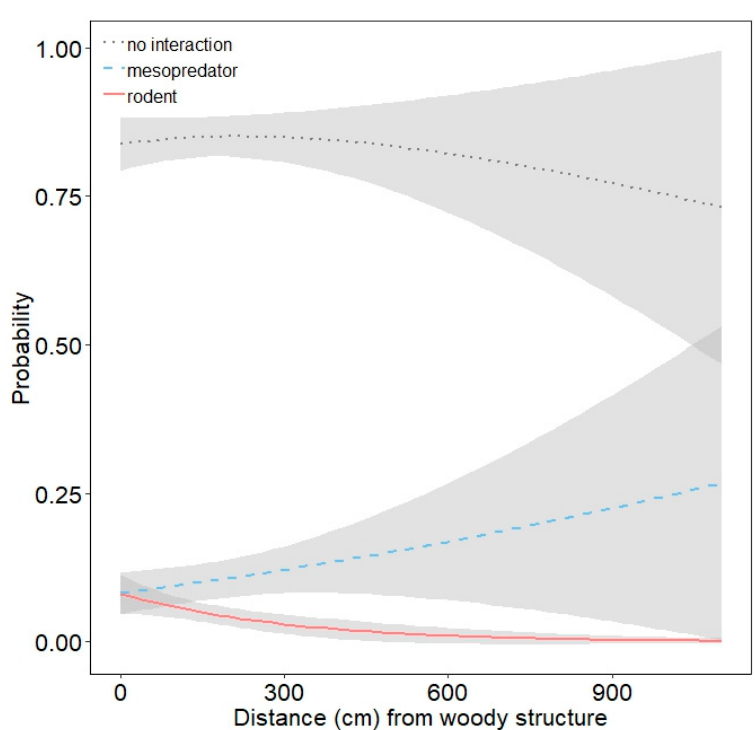
Figure 8. Probability with 85% confidence interval of mesopredators and rodents interacting with three-dimensional printed turtle models (or no interaction) as a function of distance (cm) of models from woody structure.